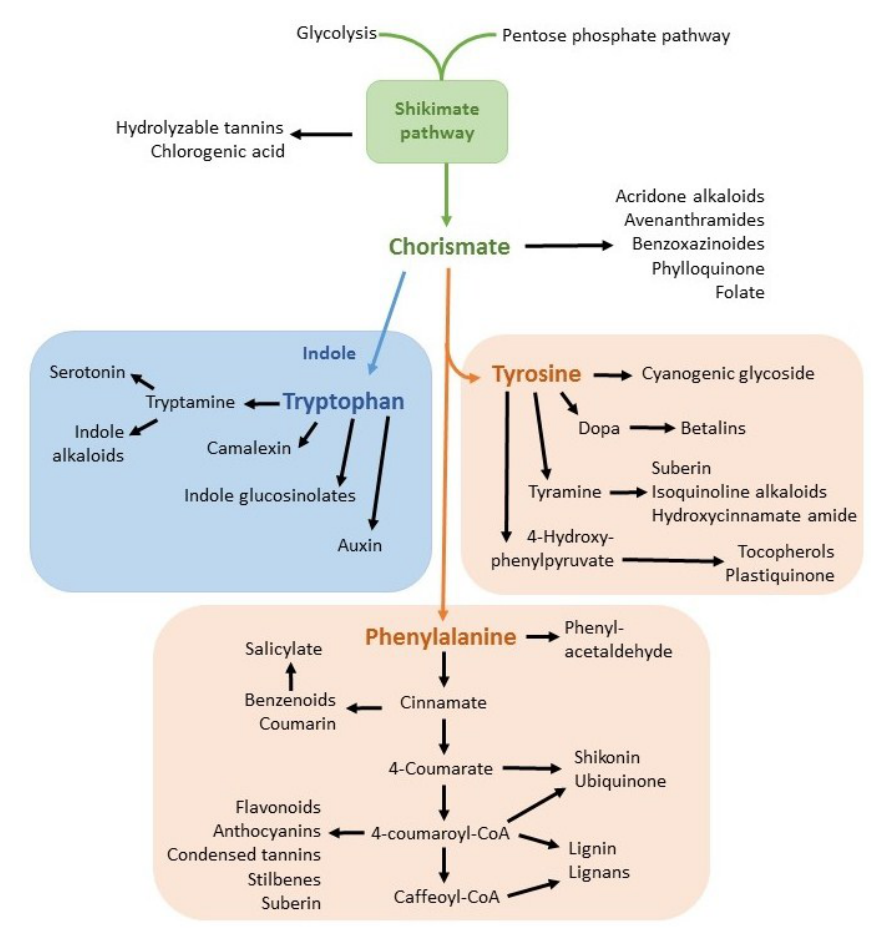
Figure 1. The shikimic acid pathway (shown in green) and selected